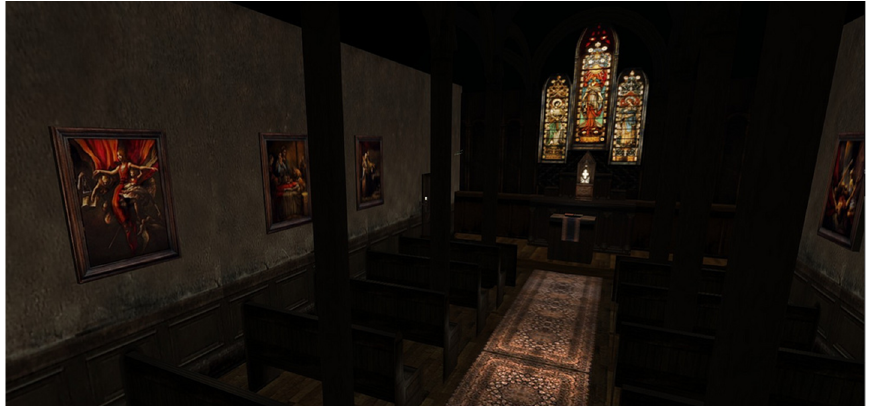
Figure 3. Example of a Virtual Church. Source by (Jamiecat 2010) .